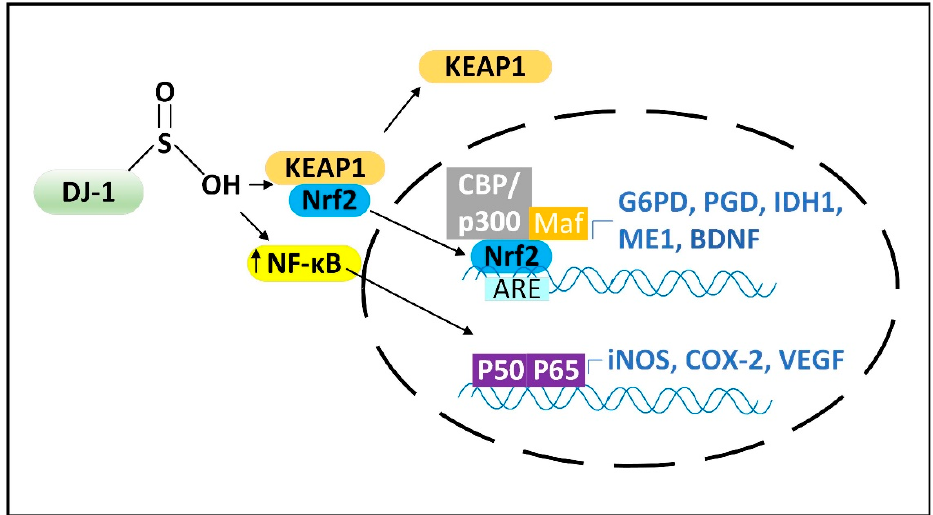
Figure 3. DJ ‐ 1 activates Nrf2 and NF ‐κ B. Active forms of DJ ‐ 1 where a cysteine is oxidized to a Figure 3. DJ-1 activates Nrf2 and NF- κ B. Active forms of DJ-1 where a cysteine is oxidized to a sulfenic sulfenic acid (not shown) or sulfinic acid activate Nrf2 and NF ‐κ B. Abbreviations: Glucose ‐ 6 ‐ phos ‐ acid (not shown) or sulfinic acid activate Nrf2 and NF- κ B. Abbreviations: Glucose-6-phosphate phate dehydrogenase (G6PD), 6 ‐ phosphogluconate dehydrogenase (PGD), brain ‐ derived neu ‐ dehydrogenase (G6PD), 6-phosphogluconate dehydrogenase (PGD), brain-derived neurotrophic rotrophic factor (BDNF), inducible nitric oxide synthase (iNOS), cyclooxygenase ‐ 2 (COX ‐ 2), vascu ‐ factor (BDNF), inducible nitric oxide synthase (iNOS), cyclooxygenase-2 (COX-2), vascular endothelial lar endothelial growth factor (VEGF). growth factor